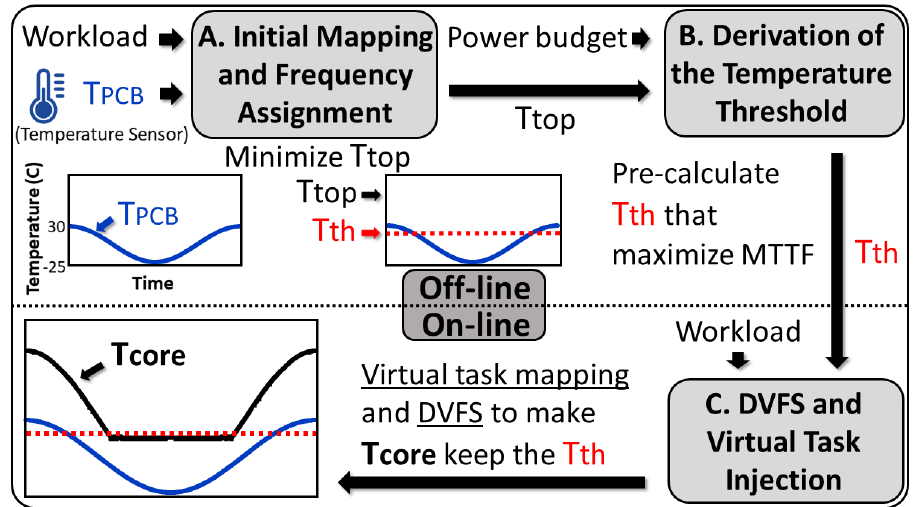
Figure 2. Overall procedure of the proposed mapping/DVFS